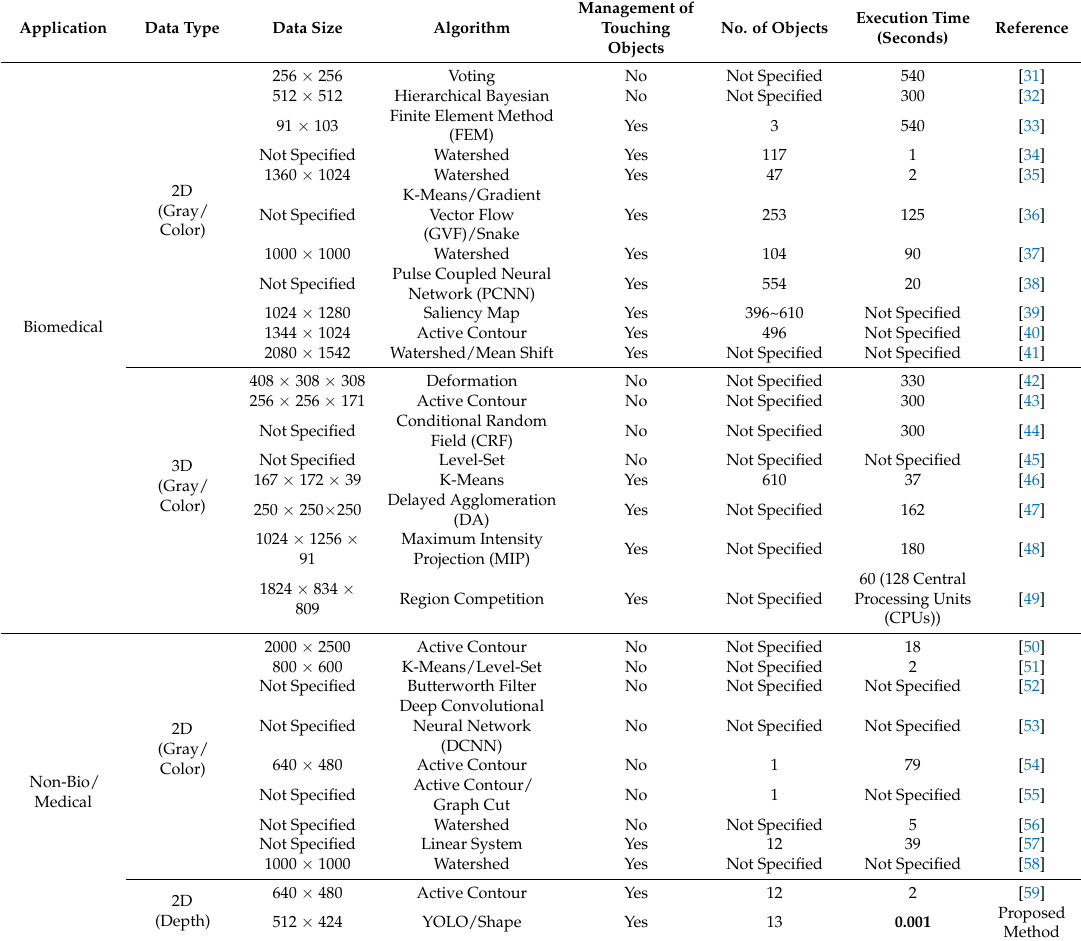
Table 1. Some of the segmentation results (published during 2012–2017). YOLO: You Only Look Once.